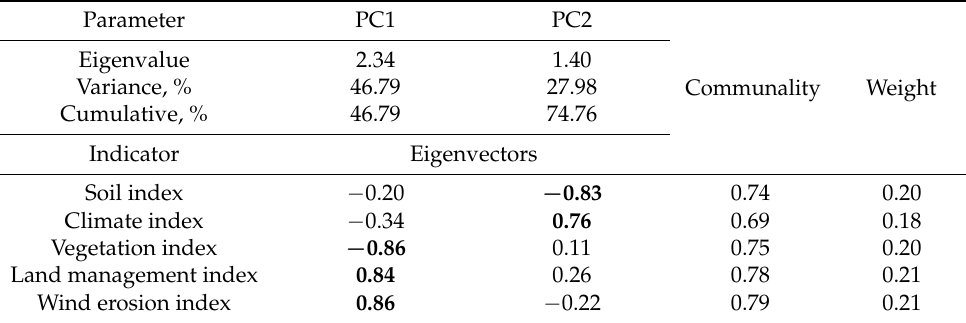
Table 7. Varimax rotated component matrix of the five quality parameters.